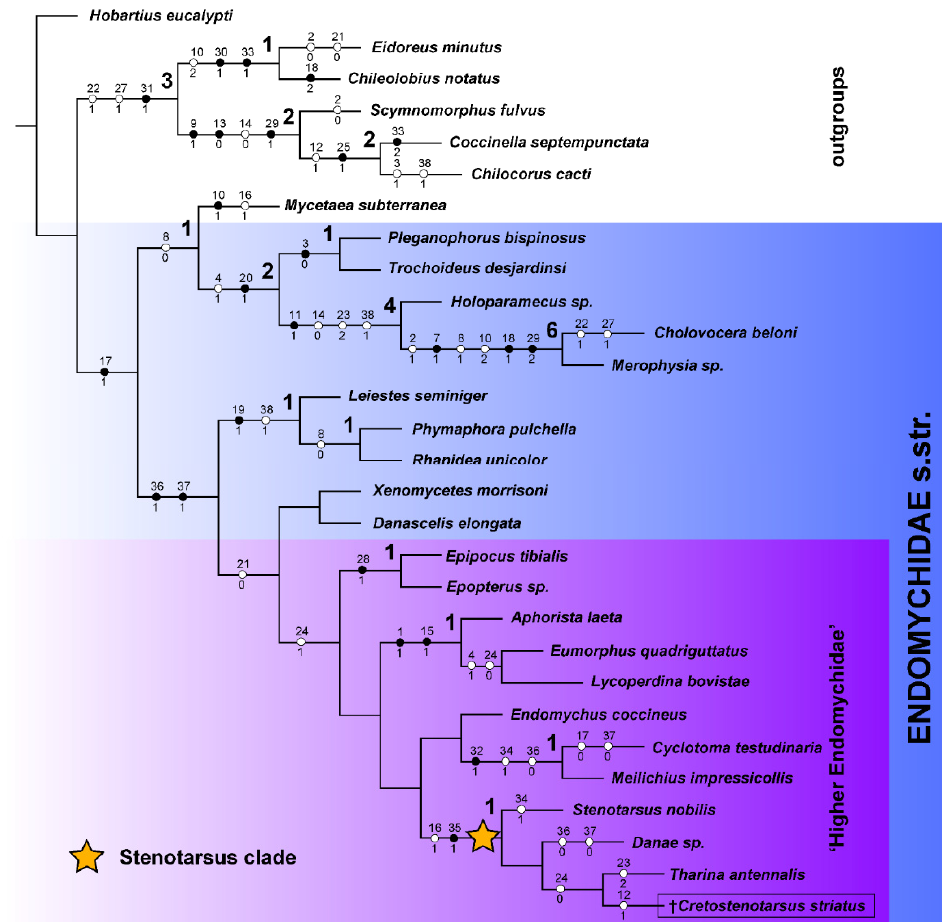
Figure 1. Single maximum parsimony tree based on morphological matrix obtained in TNT. Bremer support values are shown over the nodes. Fossil Cretostenotarsus species indicated with ‘†’ .